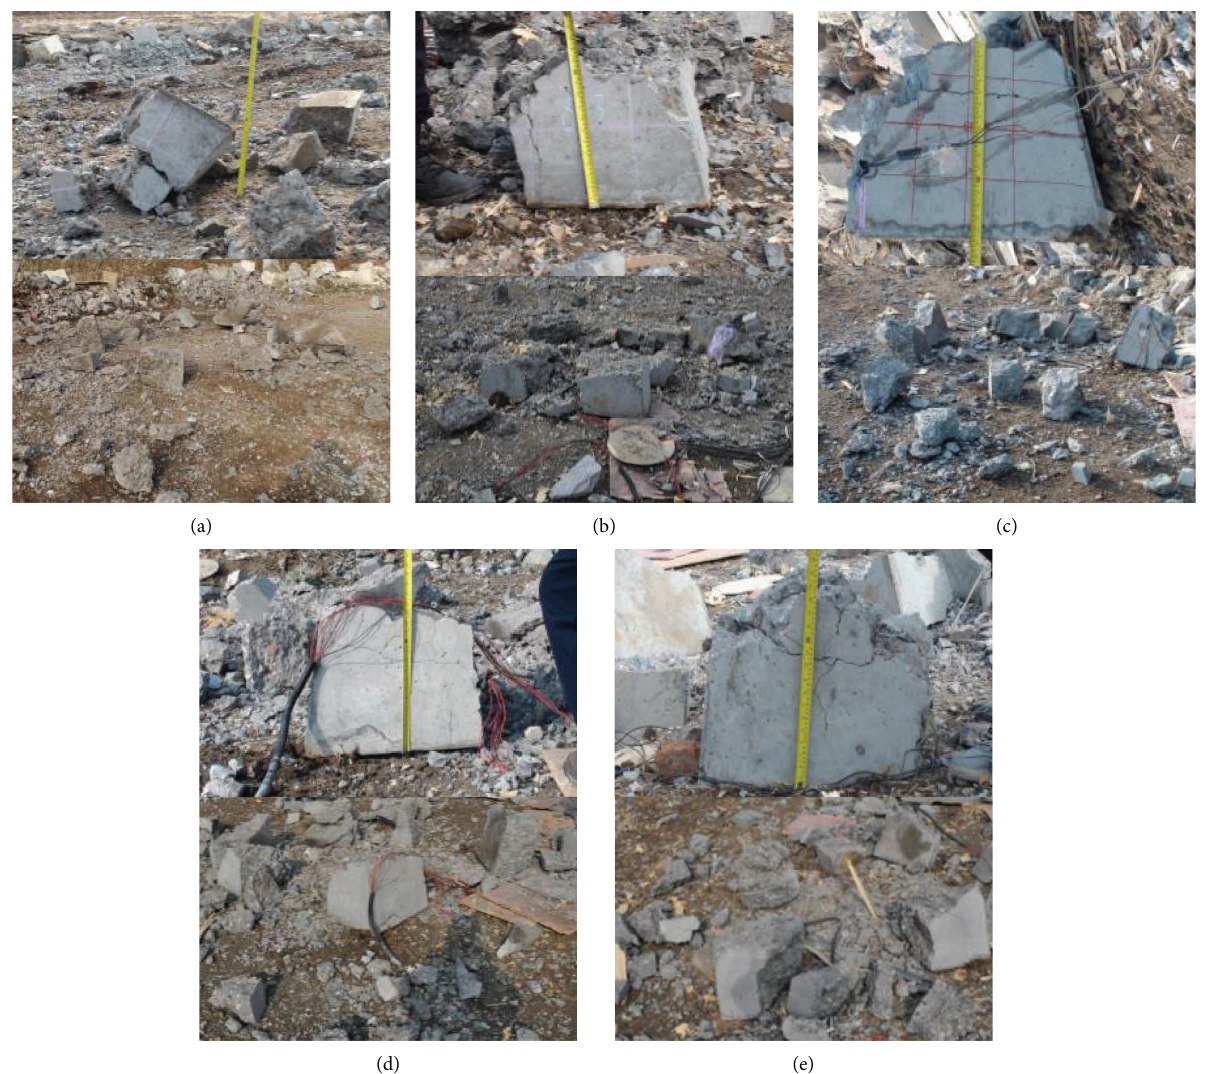
Figure 9: Damage results of the concrete piles under JPC penetration. (a) Condition 6. (b) Condition 7. (c) Condition 8. (d) Condition 9. (e) Condition 10.